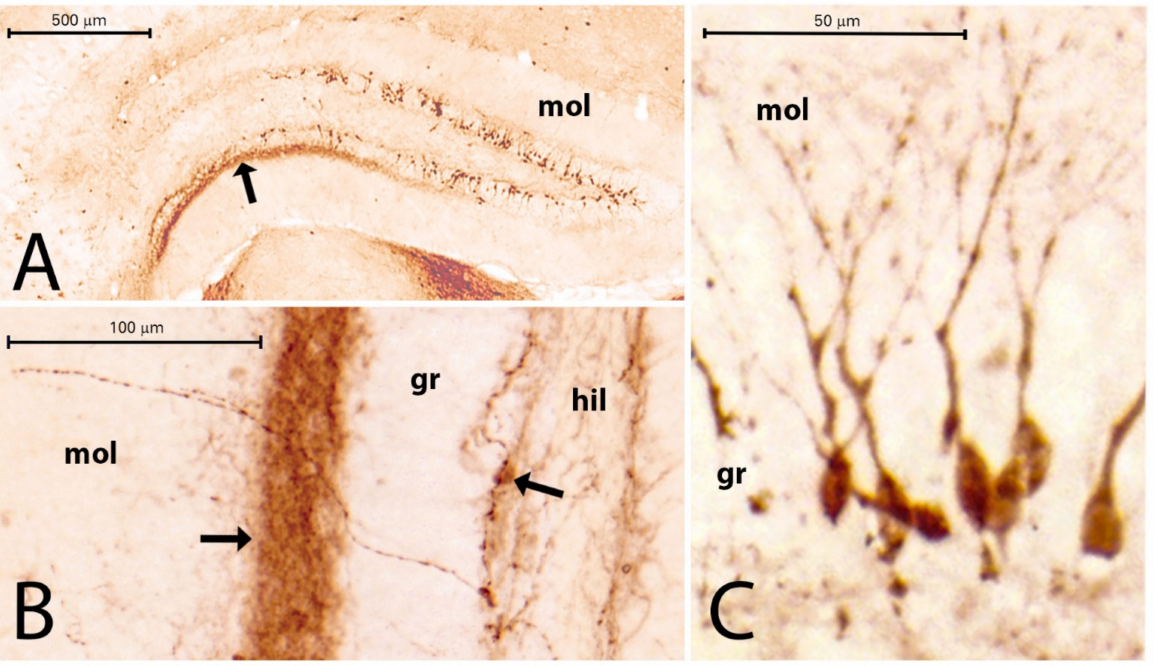
Figure 8. ( A – C ) CR staining in PT1 ( A , C ) and in PT8 ( B ). Note the numerous CR-IR granule cells in the DG of PT1 ( A , C ). The arrow in ( A ) points to the IML, where strong CR-IR cell processes are seen (mol = molecular layer of DG; bar = 500 µ m). The CR-stained IML is seen with higher magnification in ( B ) (arrow). Note the scattered, varicose CR-IR fibers in the hilum (hil) and molecular layer (mol). The black arrow in the hilum in ( B ) points to the CR-IR neuronal cell body (gr = granular layer of DG). Bar = 100 µ